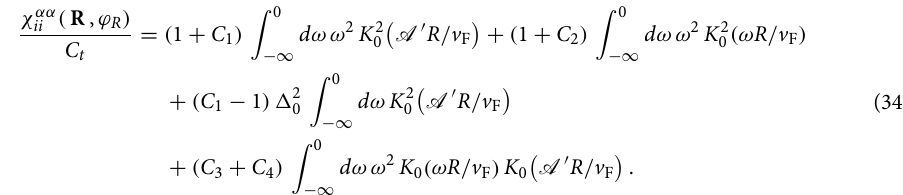
Figure 7. Long-range behavior of the RKKY interaction J RKKY αα (� 0 R / v F (cid:31) 0 at fixed long-range impurity separation R response is an exponentially decaying function independent of ϕ R and there is a minimal gap at which the response starts to switch its